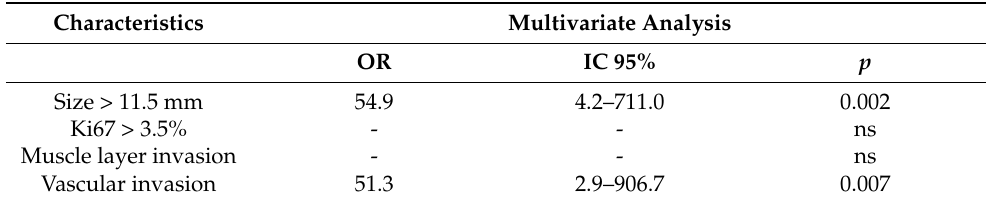
Table 2. Multivariate analysis of clinical and histopathological factors predicting nodal involvement in G1–G2 r-NEN.